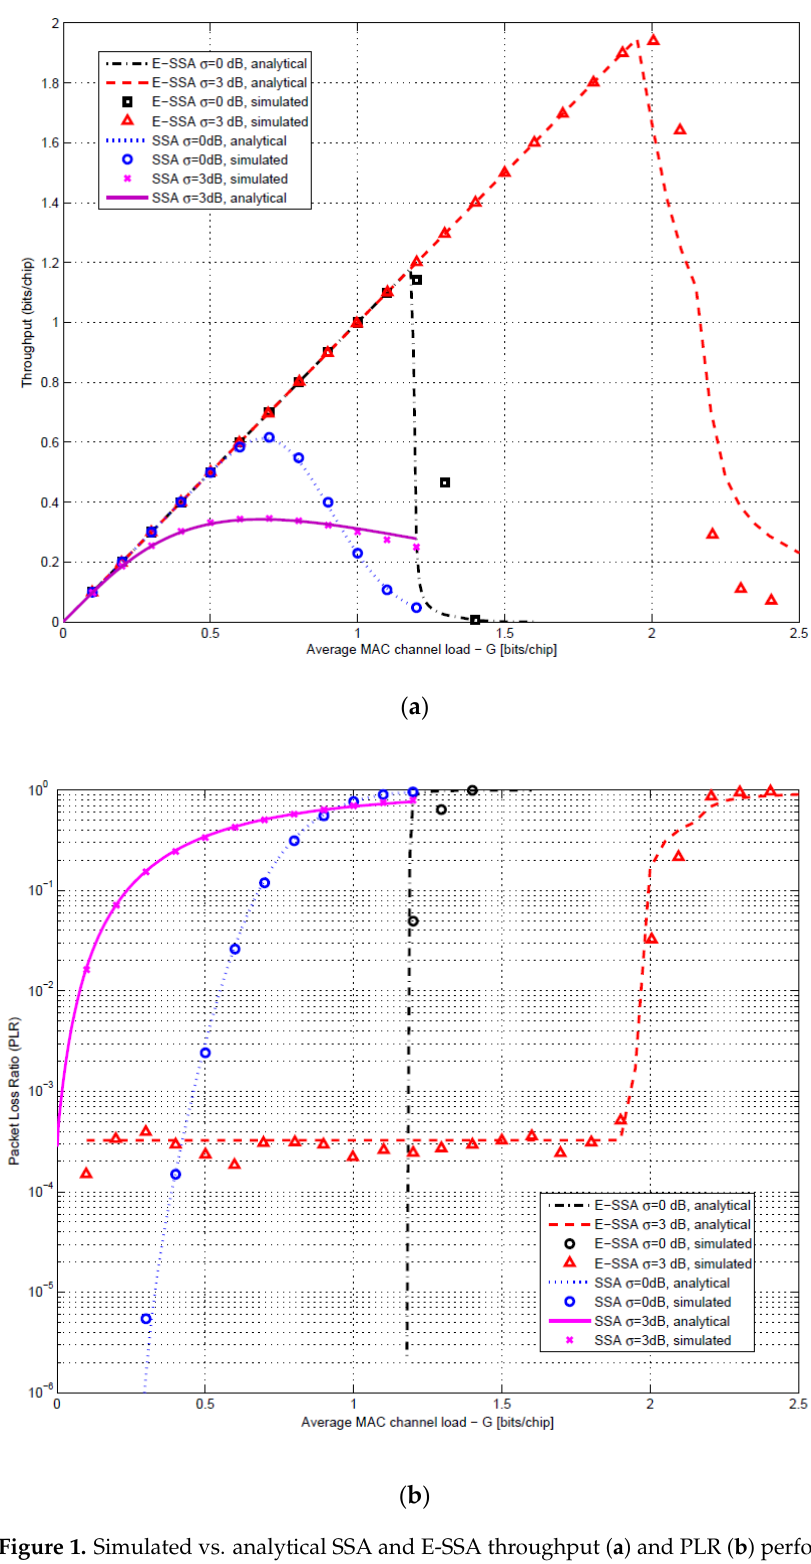
Figure 1. Simulated vs. analytical SSA and E-SSA throughput ( a ) and PLR ( b ) performance with and without lognormal power unbalance from [11], 3GPP forward error correction (FEC) code rate 1/3 with block size of 100 bits, BPSK modulation, spreading factor of 256 and E s /N 0 = 6 dB (© Copyright 2016 John Wiley and